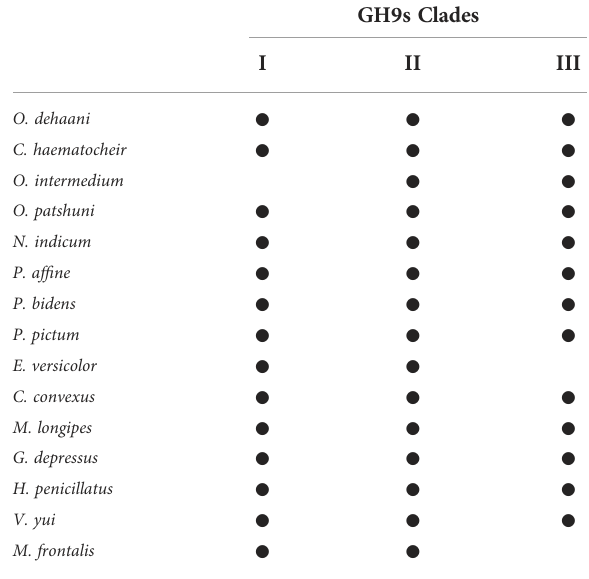
TABLE 6 Combination of GH9 clades in the grapsoid crabs investigated.